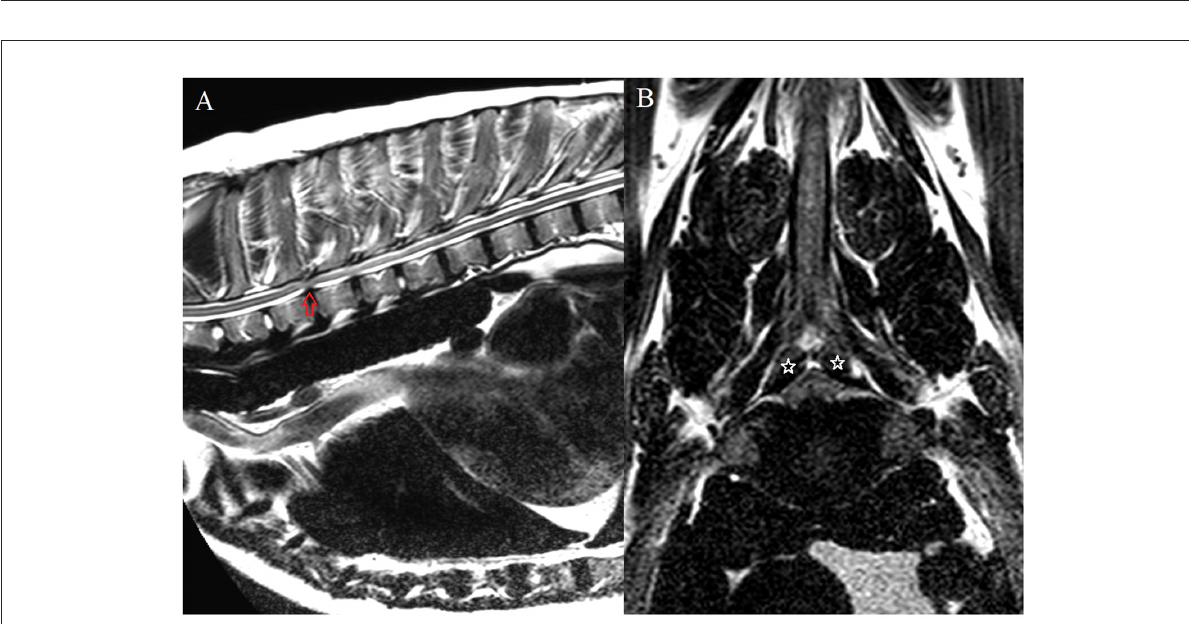
FIGURE2 MRI of case #34. Sagittal T2-weighed image of the cranial thoracic vertebral column (A) ; transverse T2-weighted image at the level of T2-T3 (B) . At this level (T2-T3), there is an intervertebral disc protrusion which resulted in moderate ventral spinal cord compression (red arrow). Additionally, there is apparent bilateral vertebral articular process hypertrophy, causing mild bilateral dorsolateral spinal cord compression (stars). This was confirmed upon surgical decompression (T2-T3 hemilaminectomy).